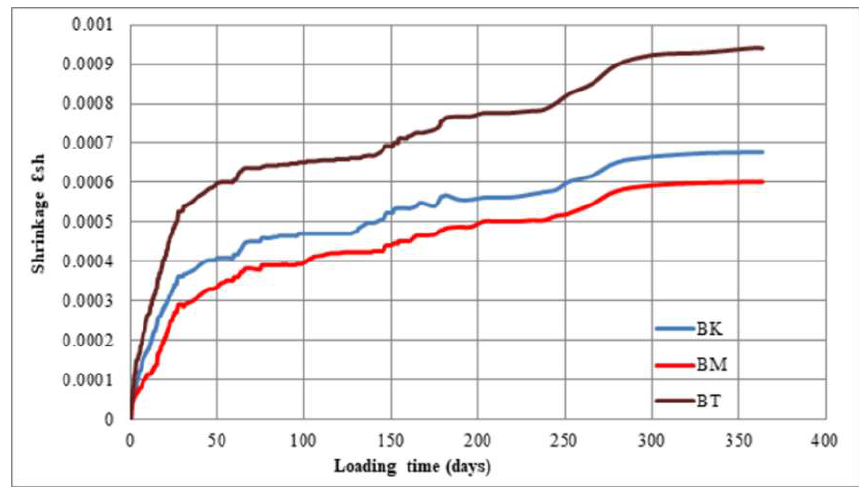
Figure 6. Development of shrinkage strains over 364